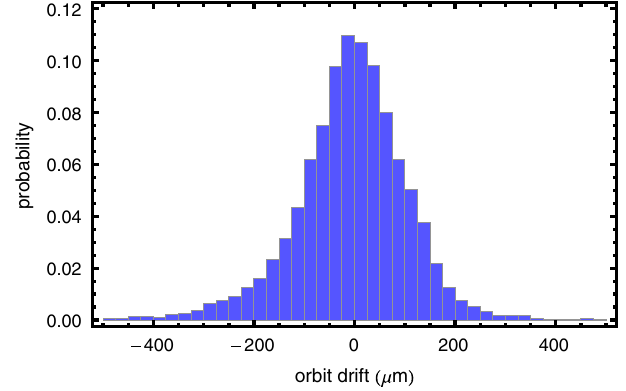
FIG. 11. The measured distribution of horizontal orbit drifts in B1 at the beam position monitors over six cells left and right of IR7. The orbit was sampled every minute during all physics fills in